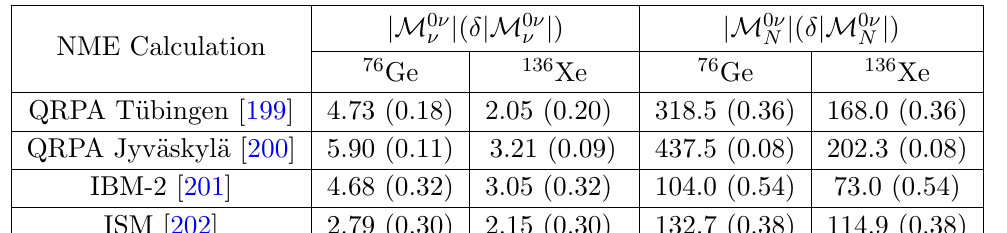
0 (cid:23) 0 (cid:23) Table 1 . Light and heavy NMEs and associated fractional uncertainties (cid:14) (cid:23) j N j jM jM 0 (cid:23) (cid:14) for 76 Ge and 136 Xe used in this work, taken from QRPA, IBM and ISM calculations in the N j jM literature, which are the only available ones that quote both light and heavy neutrino NMEs. When not explicitly given in the reference we estimate the uncertainties from the variation of NMEs with g A and the choice of short-range